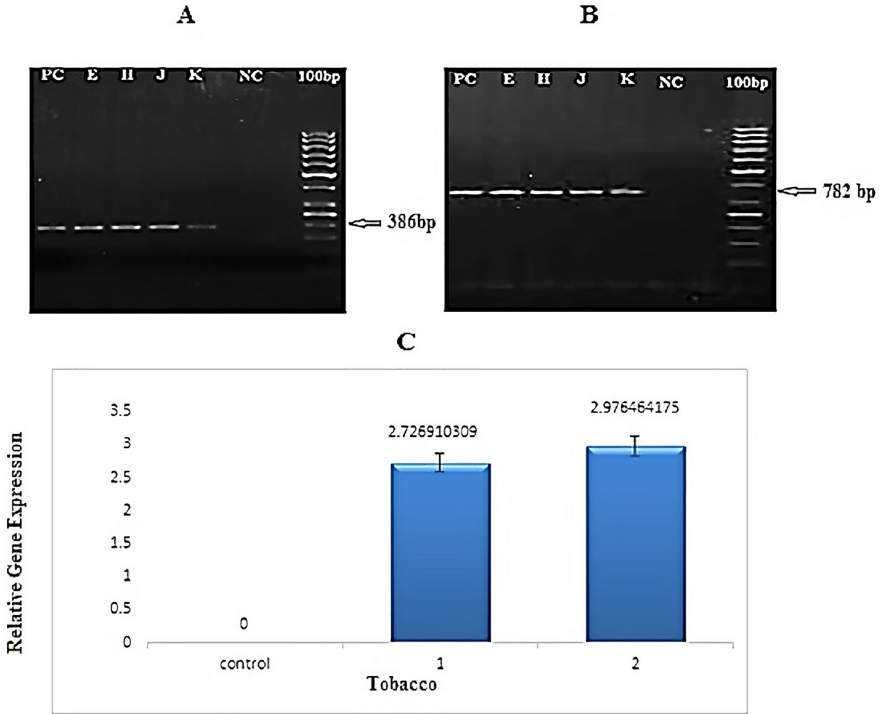
Fig 3. PCR and real-time PCR analysis of 21/Il1 β gene in transgenic tobacco plants. A : PCR product of ccl21/Il1 β in T0 transgenic lines amplified by CaMV - ccl21 primers (386bp). B : PCR product of ccl21/Il1 β in T2 transgenic lines amplified by nptII primers (798 bp). (M: 100bp size marker. NC: PCR product of wild-type plant as negative control. H, J, K, and E: PCR products of transgenic plants. PC: PCR product of pBI121- ccl21 construct as positive control). C : Quantitative measurement of ccl21/Il1 β 1 transcription in transgenic lines of tobacco via real time-PCR. 1 and 2: two samples from transgenic lines; Control: negative control (non-transgenic plant). data showed that two lines H2 and E1 did not differentiate in contrast to other lines but results showed that H2 and E1 lines with high expression level of 2.97 times and 2.72 times higher than the control (non-transgenic line), respectively.